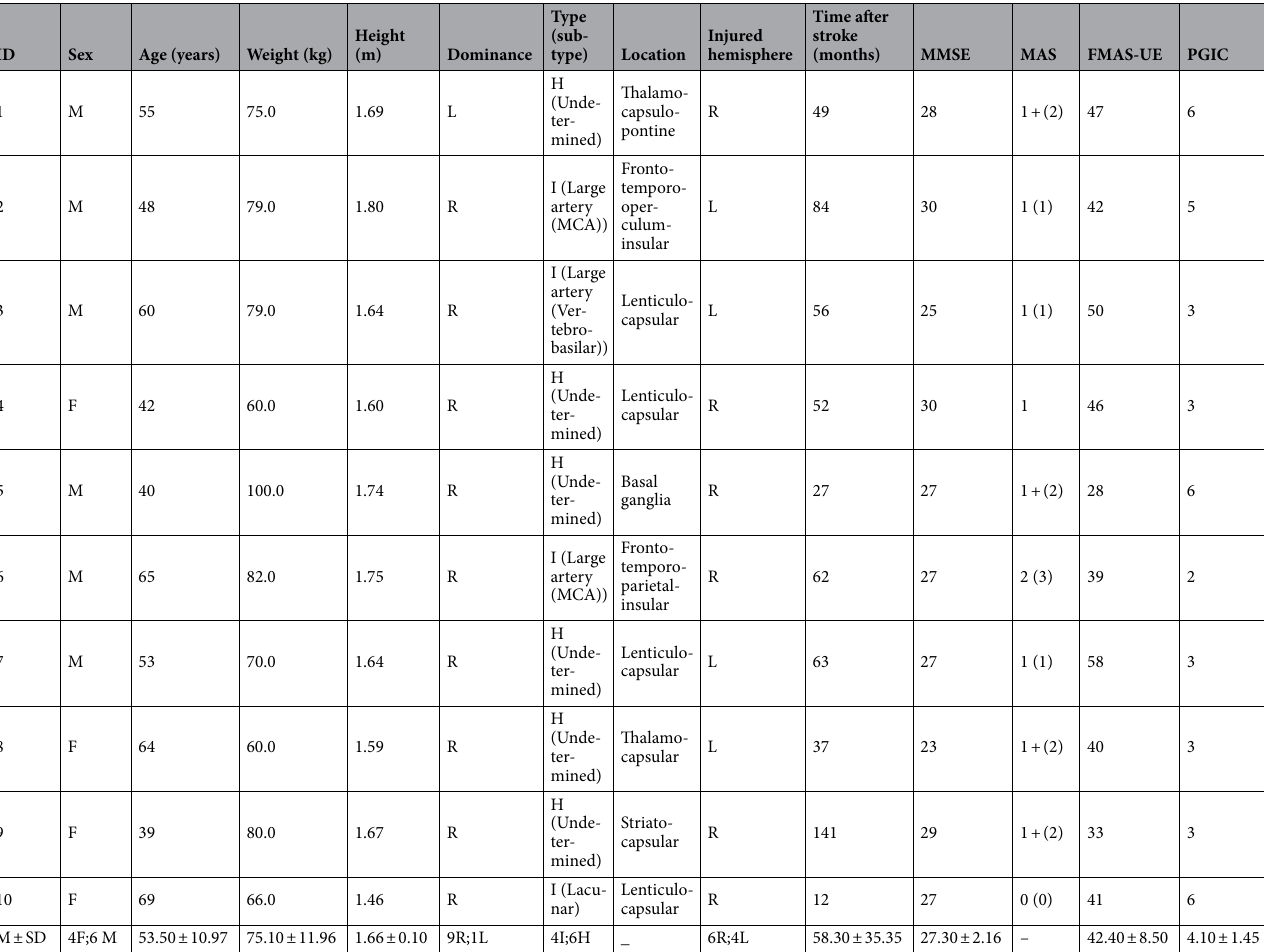
Table 1. Characterization of post-stroke participants according to sex (M: male, F: female), age (years), weight (kg) and height (m), handedness (R: right, L: left), stroke type (I: ischemic, H: hemorrhagic), sub-type (MCA: middle cerebral artery, ICA: internal carotid artery) and location, injured hemisphere (R; L), time after stroke (months) and the scores of the Mini-Mental State Examination (MMSE), Fugl-Meyer Assessment Scale-Upper Extremity (FMAS-UE), Modified Ashworth Scale (MAS), and Patient Global Impression of Change